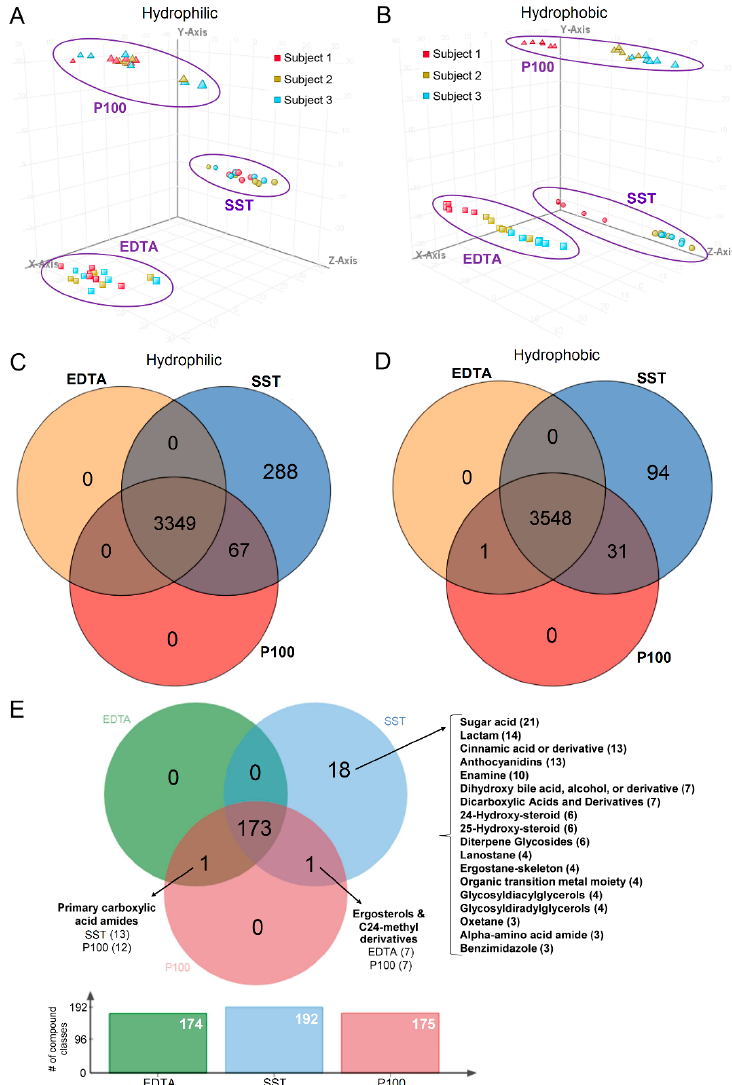
Figure 1. Comparison of sample tubes. ( A ) PCA plot on data shows clustering on tube type in the hydrophilic fraction. x-axis : PC1, 18.93%; y-axis : PC2, 16.83%; z-axis : PC3, 4.52%. ( B ) PCA plot on samples shows clustering on tube type and subject in the hydrophobic fraction. x-axis : PC1, 23.56%; y-axis : PC2, 20.9%; z-axis : PC3, 4.2%. PCA was performed using all metabolites prior to filtering and statistical analysis. ∆ P100, ○ SST, □ EDTA. ( C ) Overlap of metabolites in the hydrophilic fraction. ( D ) Overlap of metabolites in the hydrophobic fraction. Compounds were filtered for presence in 50% of at least one time point in each tube. ( E ) Venn diagram of taxonomy showing the overlap of shows the name of the unique compound classes, the tube type and the number of compounds from compound classes that passed enrichment analysis based on FDR ≤ 0.05. The overlapping